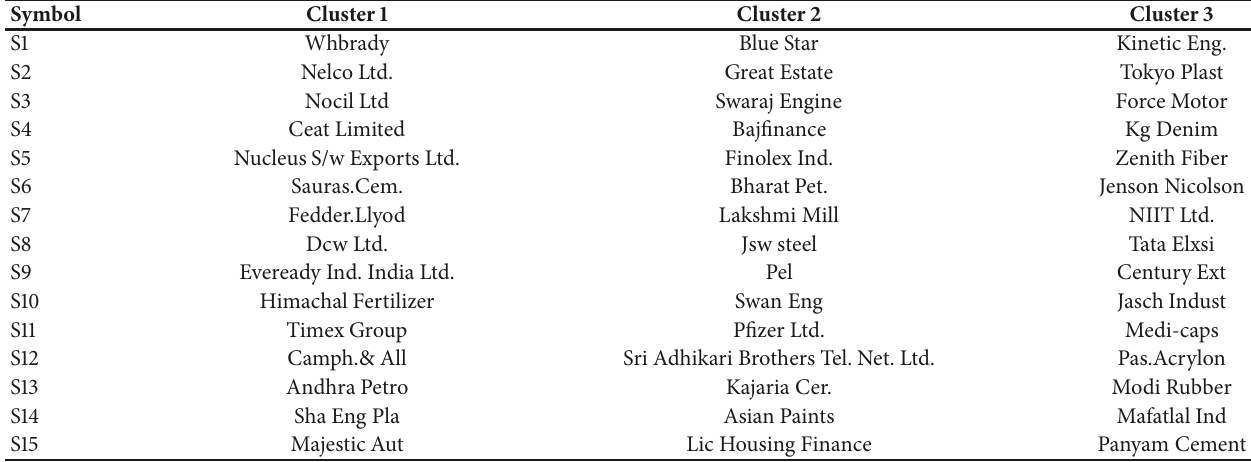
Table 2: Stocks for each